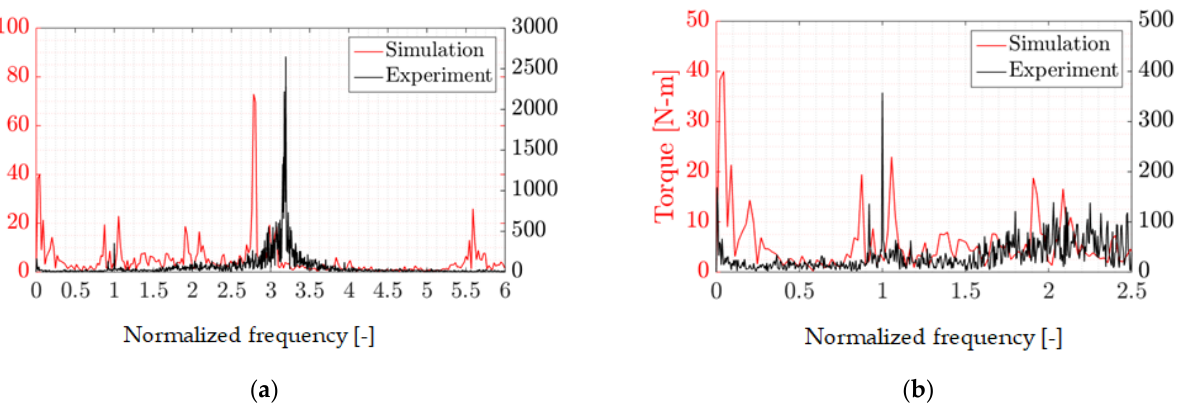
Figure 10. ( a ) Amplitude spectrum of the torque. ( b ) Low-frequency spectrum. Two vertical axes are used; numerical results—red, experimental